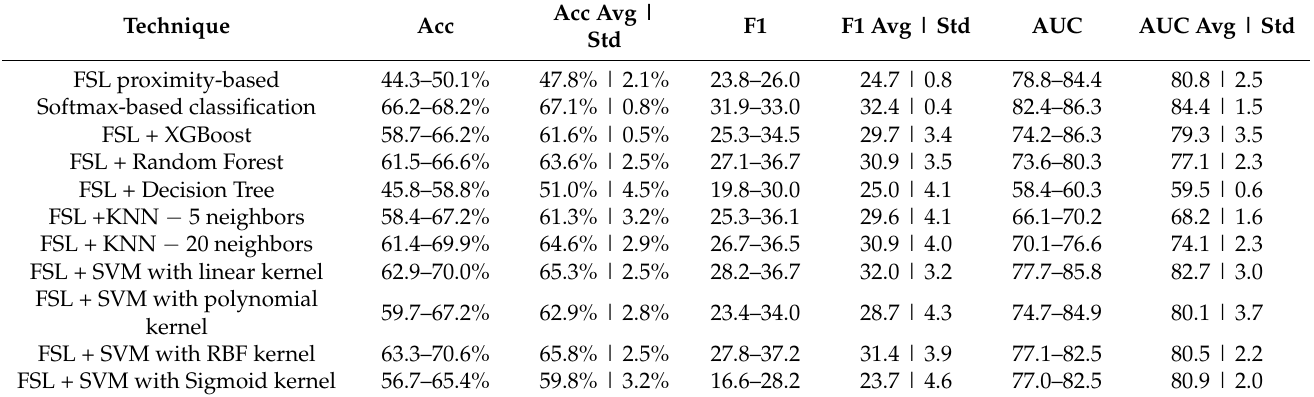
Table 6. Results for 20-class classification, part I.